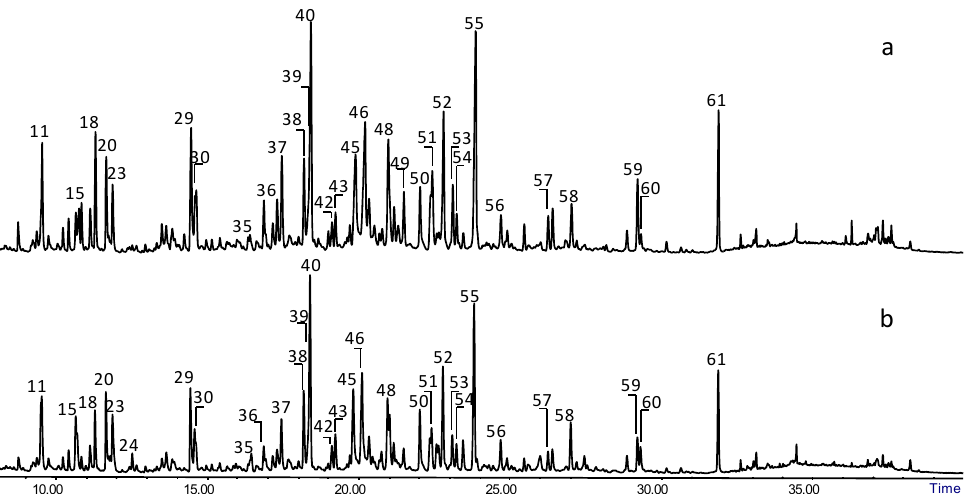
Figure 3. Py-GC-MS chromatographic profiles obtained for archaeological wood sample ( a ) S2 (spruce) and ( b ) P2 (pine). Numbers refer to Table 5.